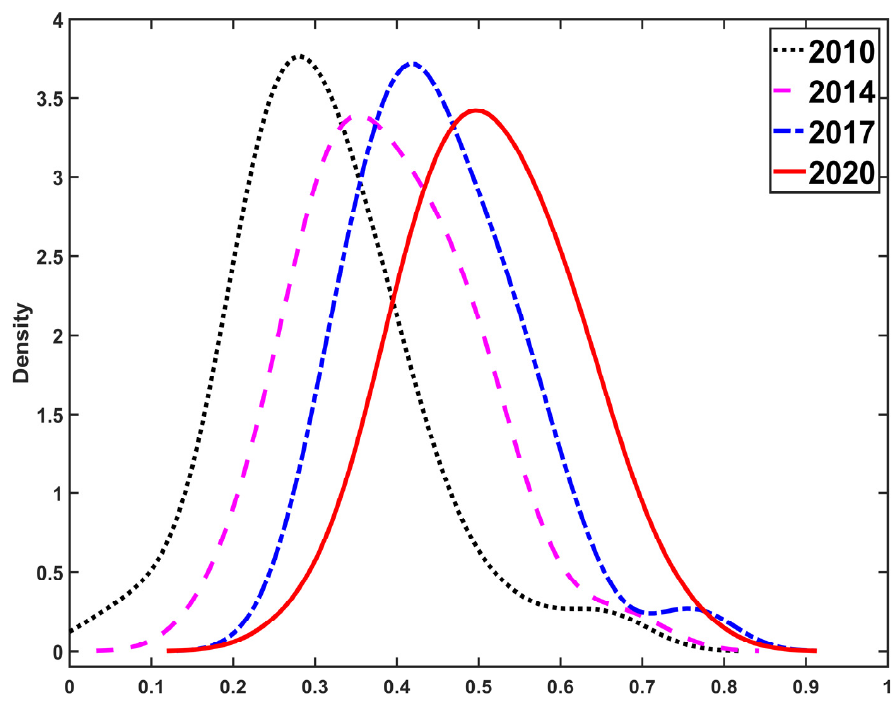
Figure 8. Kernel density estimations results of well-being scores in 2011, 2014, 2017, and 2020.